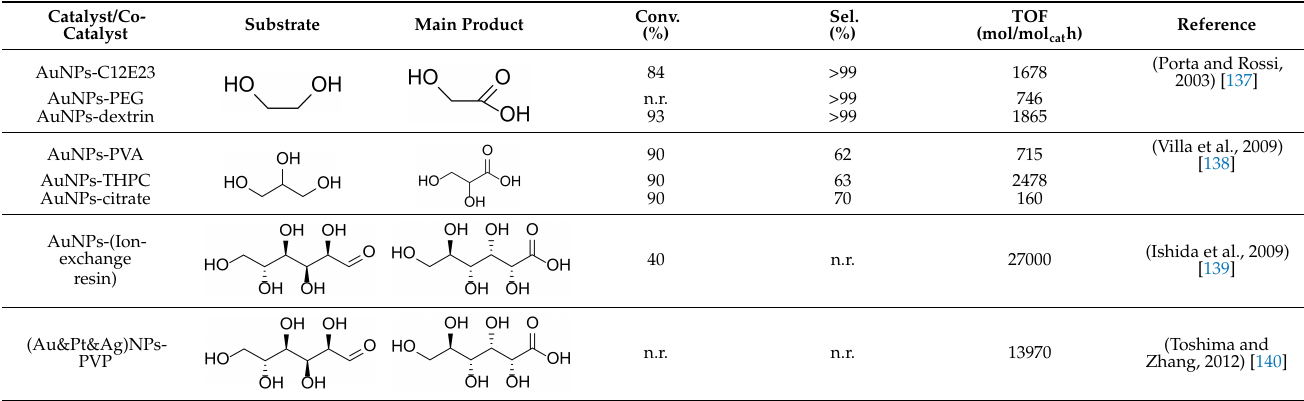
Table 4. Aerobic oxidations of polyols promoted by polymer supported